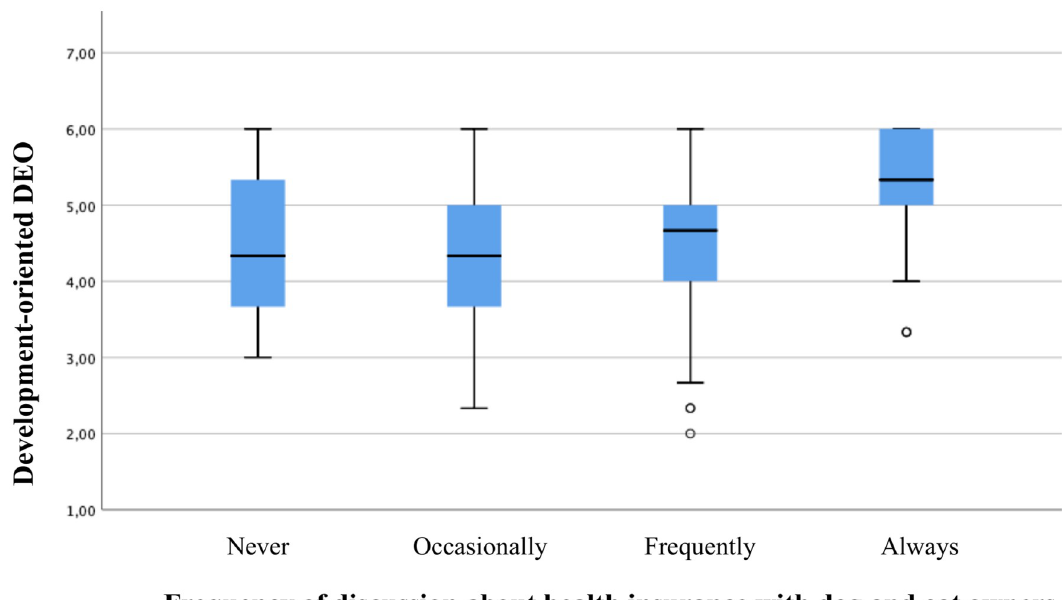
Fig 3. Box plots showing level of development-oriented DEO with respect to frequency of discussion about health insurance for UK veterinarians. In the box plots, the boundary of the box closest to zero indicates the first quartile, the thick black within the box marks the median, the boundary of the box farthest from zero indicates the third quartile. Whiskers above and below the box indicate 10th and 90th percentiles. Points below the whiskers indicate outliers outside the 10th and 90th percentiles.